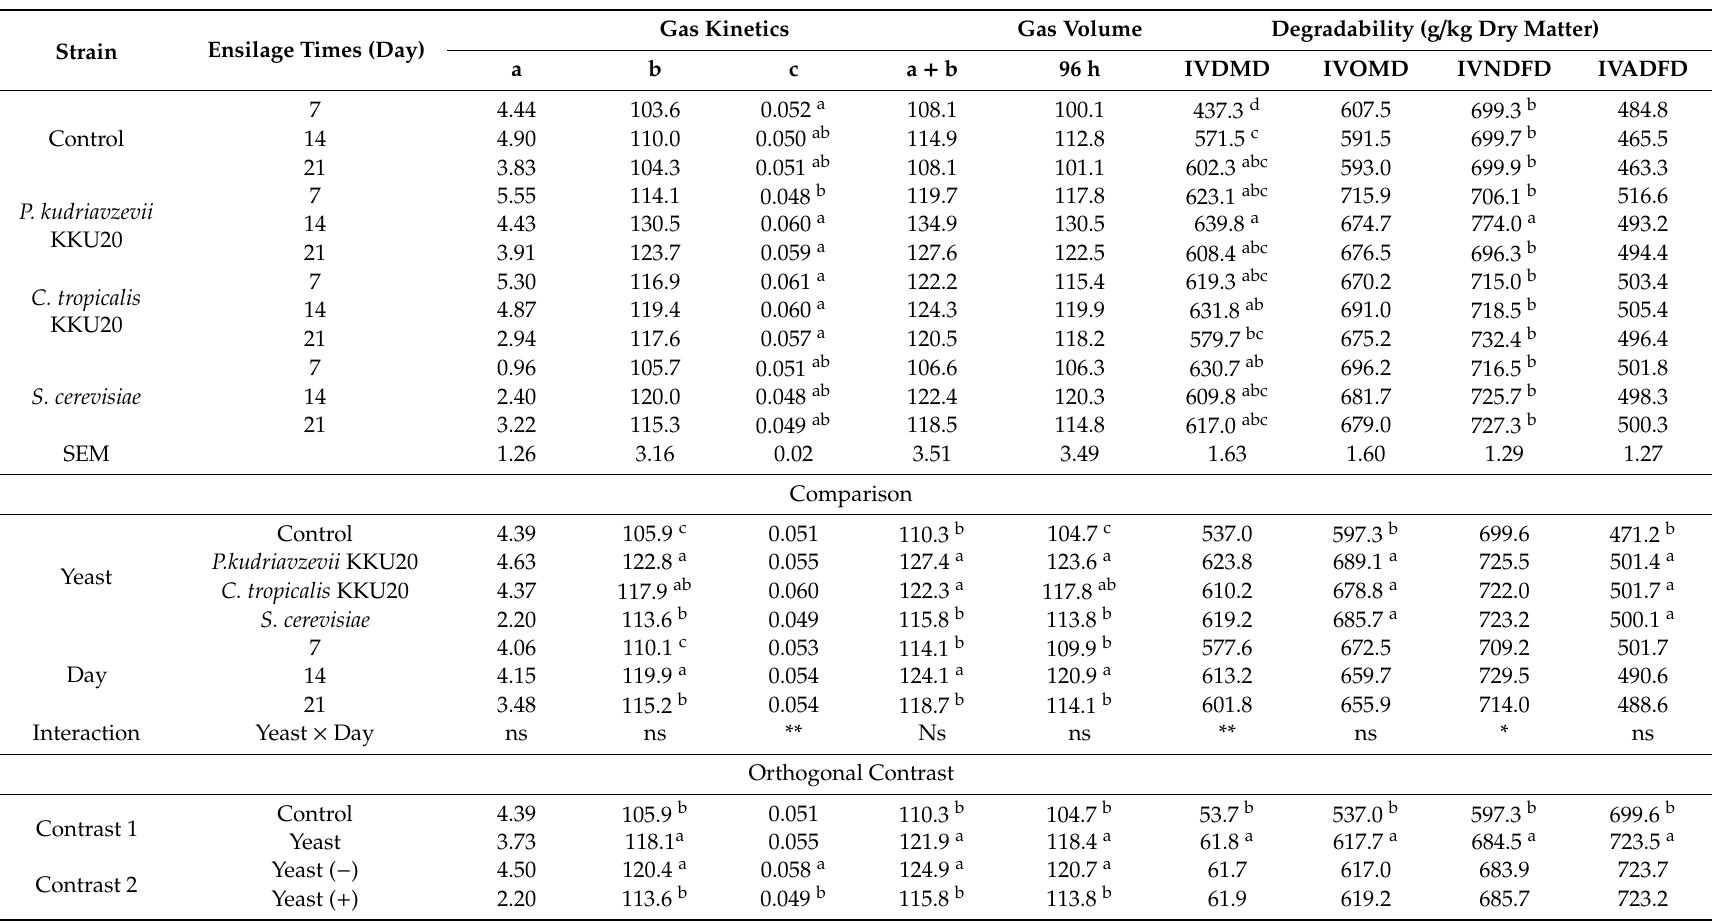
Table 4. Gas production kinetics and degradability of rice straw fermented with Crabtree-negative and -positive yeasts from in vitro incubation.